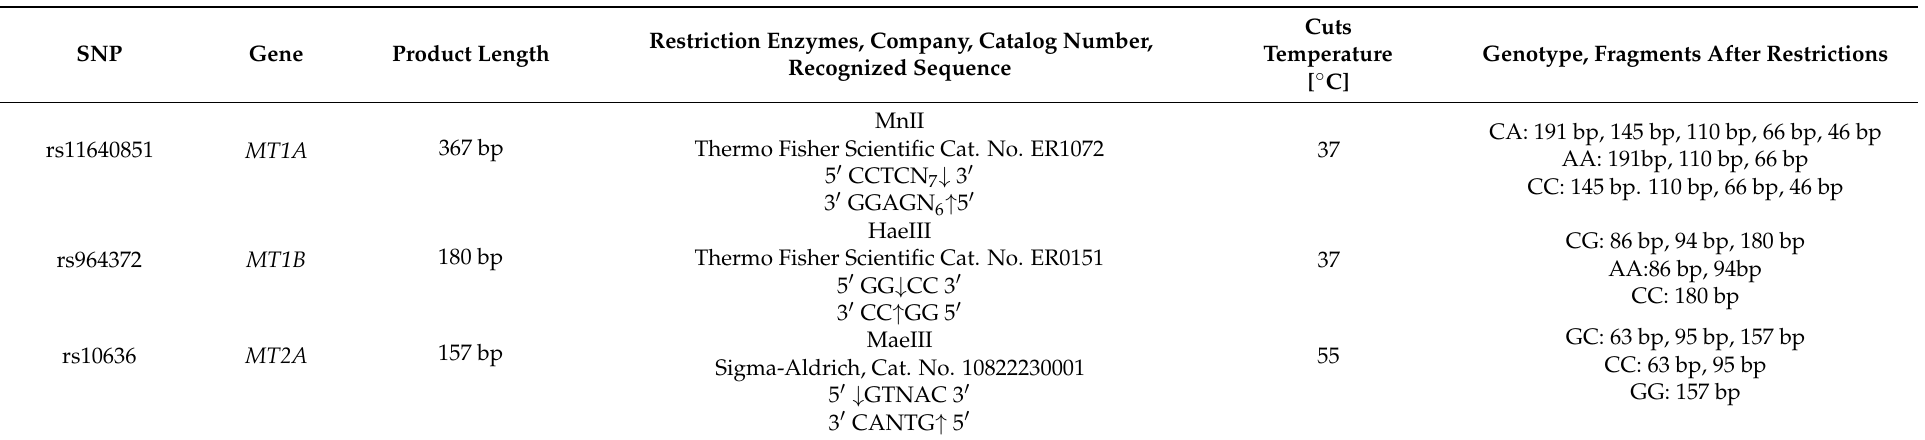
Table 11. The digestion conditions of PCR products with restriction